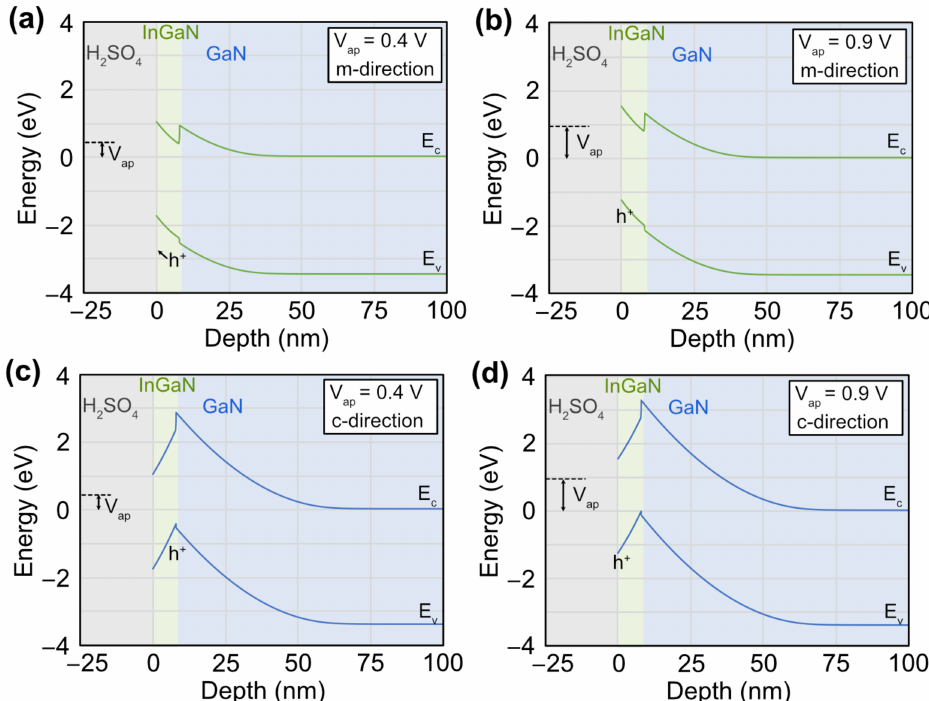
Figure 7. Simulated band diagram for the InGaN/GaN structure at applied potentials versus the reference electrode and directions of ( a ) 0.4 V and ( b ) 0.9 V for the m -direction, and ( c ) 0.4 V and ( d ) 0.9 V for the c -direction. The dotted line is the energy of the reference electrode. The polarization fields create a well at the InGaN/GaN interface for the c -direction, where holes can collect ( d ). At a potential of 0.9 V, the InGaN surface is p-type, and the applied potential alone promotes etching and allows for both orientations to etch. At a potential of 0.4 V, the InGaN surface is n-type, and holes generated by the absorbed light are easier to collect on the m -plane surface than the c -plane. The y-axis is positioned, so the Fermi-energy level in the GaN template is at 0 eV, but it can be recalibrated to the reversible hydrogen electrode using the Nernst